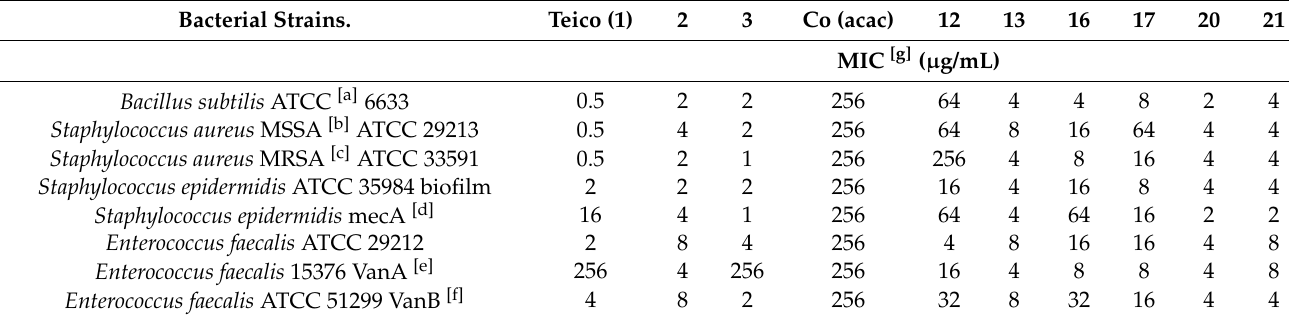
Table 1. Antibacterial